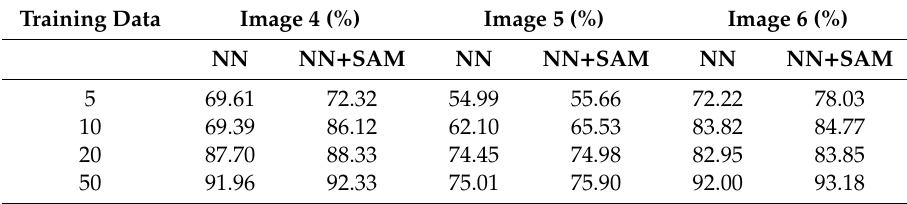
Table 3. Average classification accuracies for the second image set with ANN and proposed